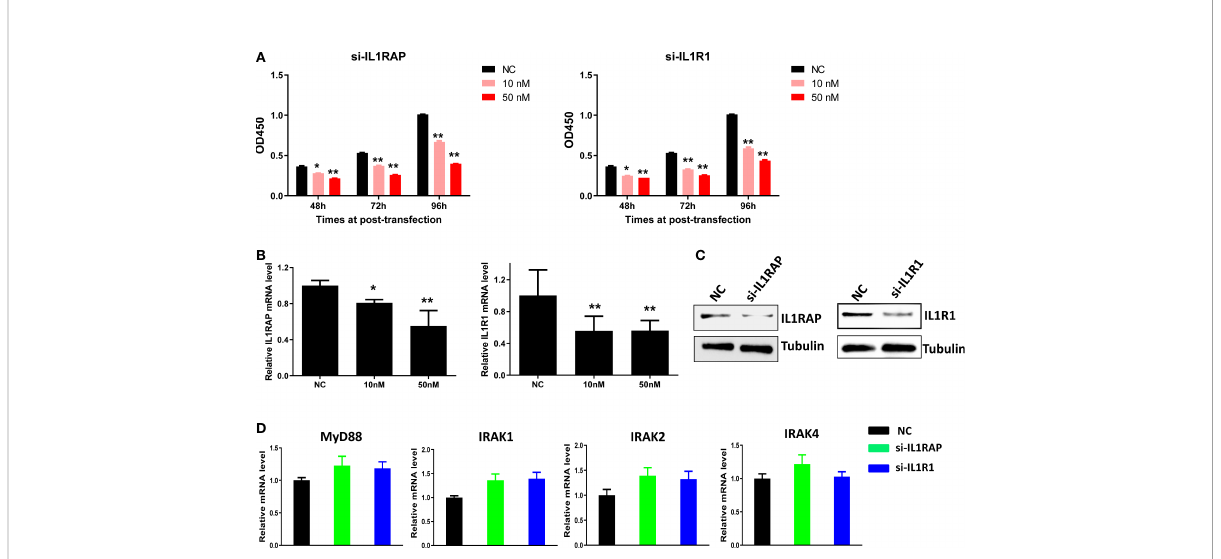
FIGURE 3 Targeting IL1RAP and IL1R1 by RNAi inhibits the growth of BCBL-1 PEL cells. (A) BCBL-1 were transfected with 10 nM or 50 nM of IL1RAP-siRNA, IL1R1-siRNA or non-target control siRNA (NC at 50 nM) (Dharmacon SMARTpool siRNA) for 48-96 h, then the cell proliferation was measured using the WST-1 assays. (B – D) Cells were transfected as above for 72 h, then the target genes transcription was measured using RT-qPCR. The protein expression was measured using Western blot, and representative blots from one of two independent experiments were shown. Error bars represent S.D. for 3 independent experiments, *p<0.05, **p<0.01.